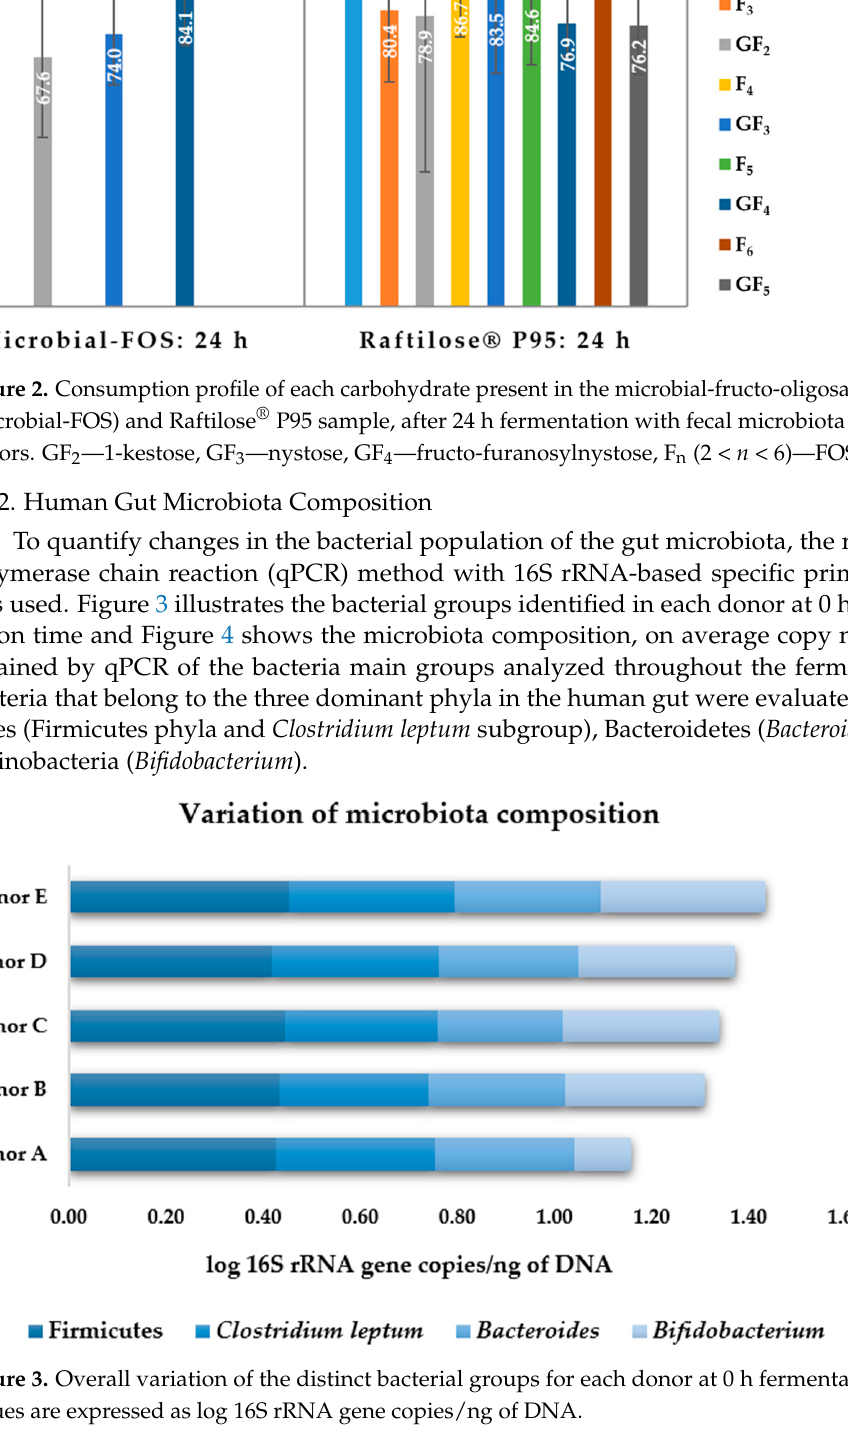
Figure 4. Variation of Firmicutes, Clostridium leptum , Bacteroides, and Bifidobacterium from five microbiota donors during fermentation with microbial-fructo-oligosaccharides (FOS), Raftilose ® P95 and without carbon source (negative control). Values are expressed as log 16S rRNA gene copies/ng of DNA through time (h), with standard deviation bars; a, b, c means statistically significant differences ( p < 0.05) between: a—microbial-FOS and negative control, b—microbial-FOS and Raftilose ® P95, c—Raftilose ® P95 and negative control. Similar microbiota composition was determined for all participants, with exception of donor A, for which the abundance of the Bifidobacterium genus was lower than the other donors (Figure 3).